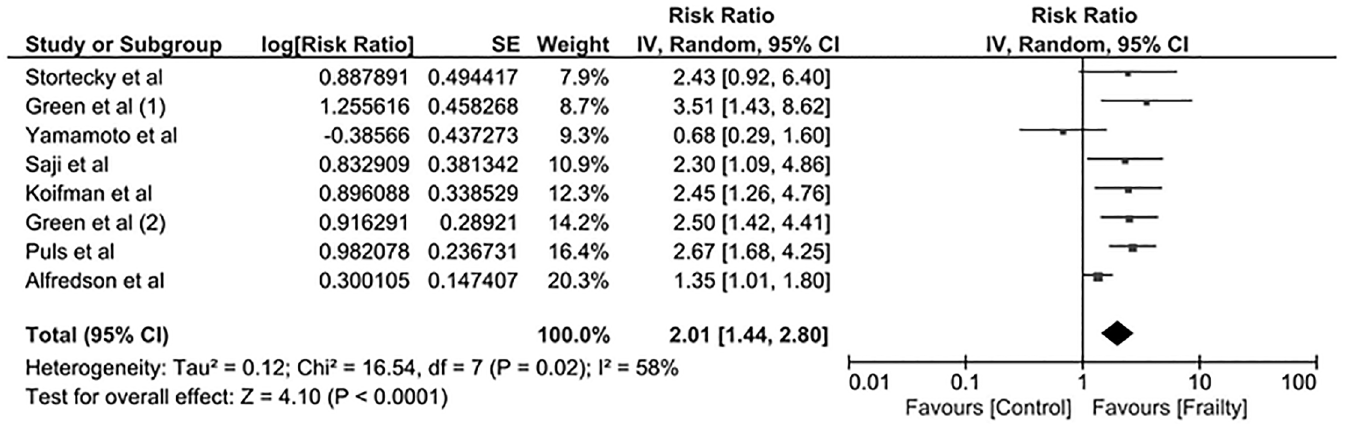
Fig 3. Forest plot of included studies comparing the risk of mortality after TAVR in frail vs. non-frail patients. Square data markers represent risk ratios (RRs); horizontal lines represent the 95% CIs with marker size reflecting the statistical weight of the study using random-effects model. A diamonddata marker representsthe overall RR and 95% CI for the outcome of